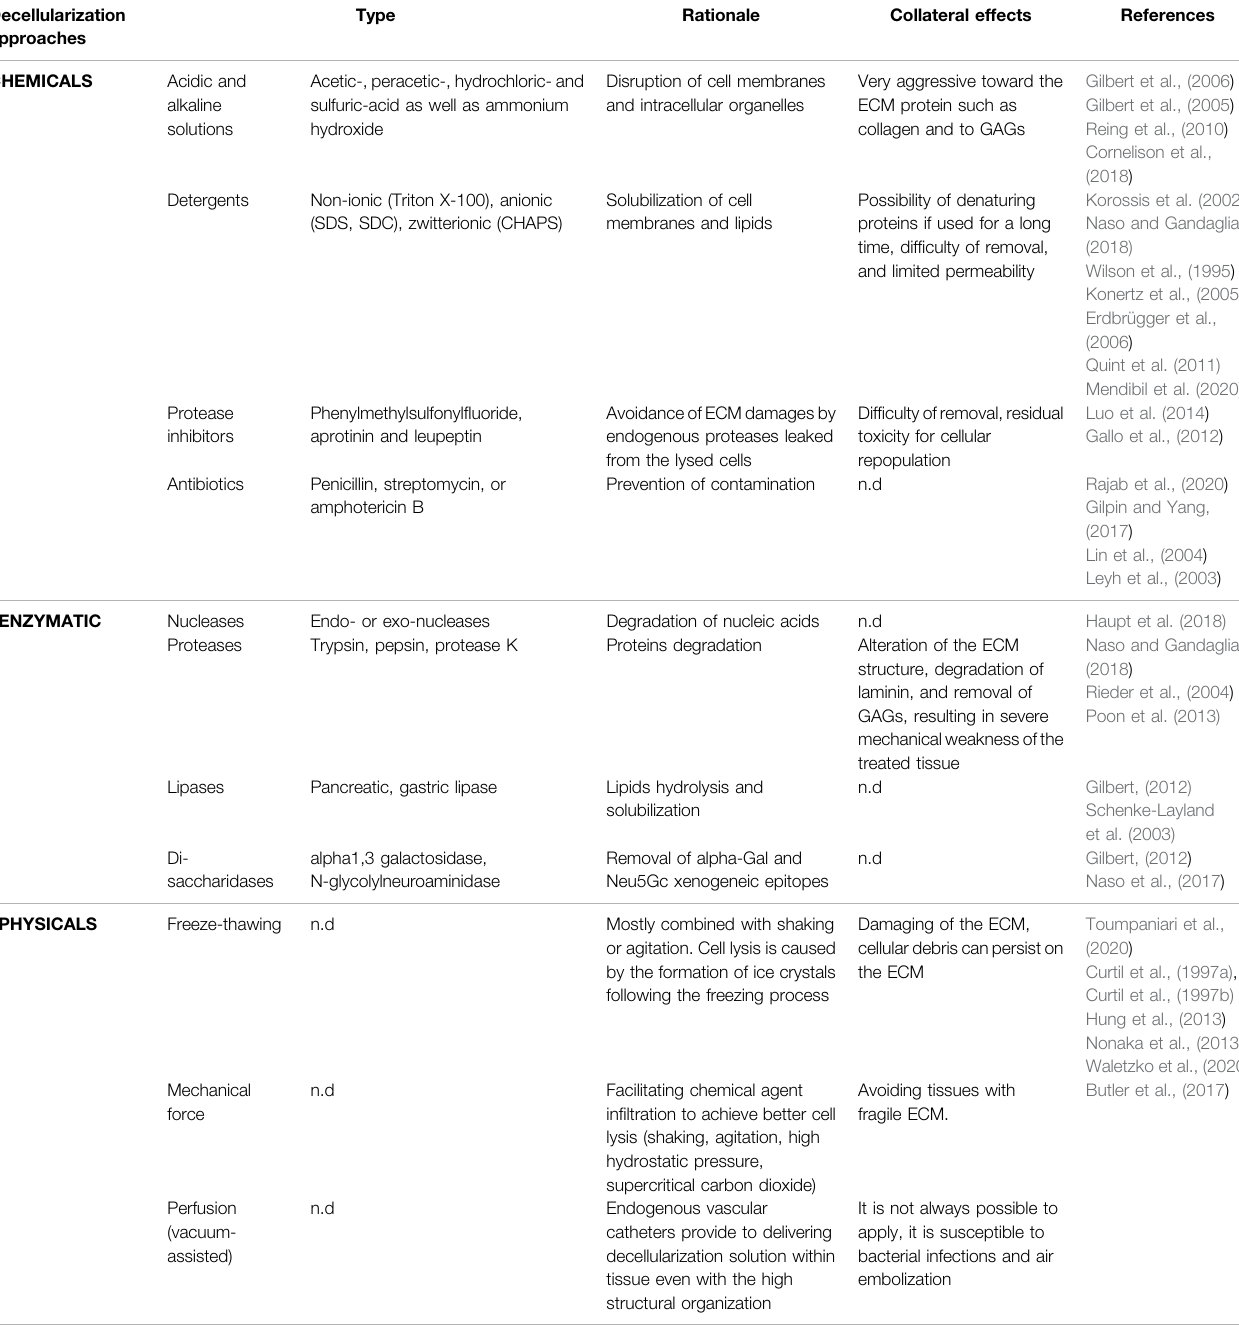
TABLE 2 | The most common decellularization